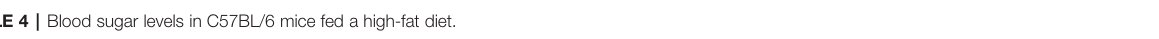
TABLE 4 | Blood sugar levels in C57BL/6 mice fed a high-fat diet. Time